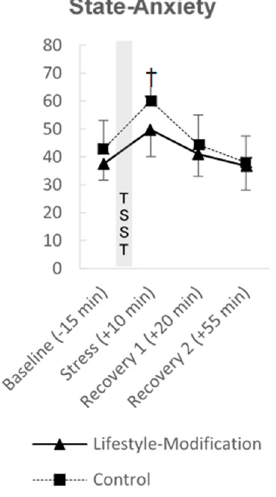
Figure 4. Results of the exploratory sub-study: State anxiety as measured with the state version of the State-Trait Anxiety Inventory in patients of the lifestyle-modification group ( n = 8) and controls ( n = 8). Results are expressed as mean ± standard deviation. † p < 0.10.